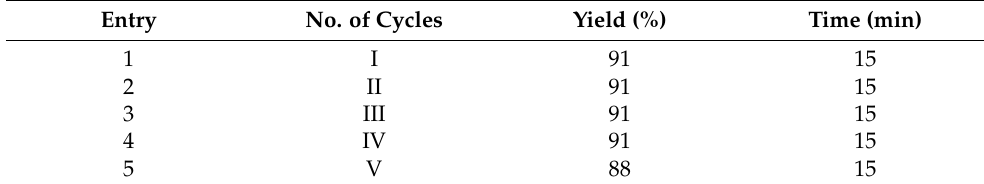
Table 4. Recycling study of catalyst on the model